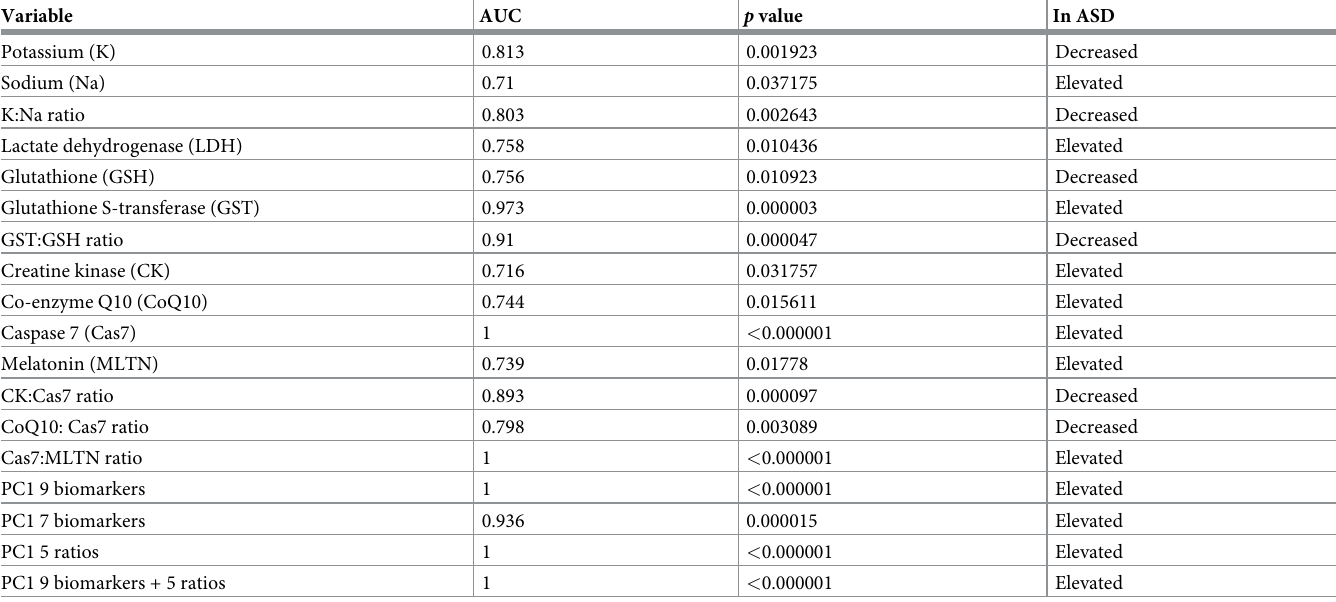
Table 2. Estimating the predictive power of variables using the area under a receiver operating characteristic curve (AUC). The p value indicates asymptotic signifi- cance with the null hypothesis being that the true AUC is equal to 0.5. The far-right column shows whether the variable is elevated or decreased in autistic patients (ASD) compared to healthy controls. PC1: first principal component in a principal component analysis used as a multivariate biomarker profile. The number of individual bio- markers used in each profile is indicated. The 9 biomarkers (K, Na, LDH, GLTN, GST, CK, CoQ10, Cas7, and MLTN); 7 biomarkers (K, Na, LDH, GSH, CK, CoQ10, and MLTN); 5 ratios (K:Na, GST:GLTN, CK:Cas7, CoQ10: Cas7, and Cas7:MLTN); 9 biomarkers and 5 ratios; or K, GST, and